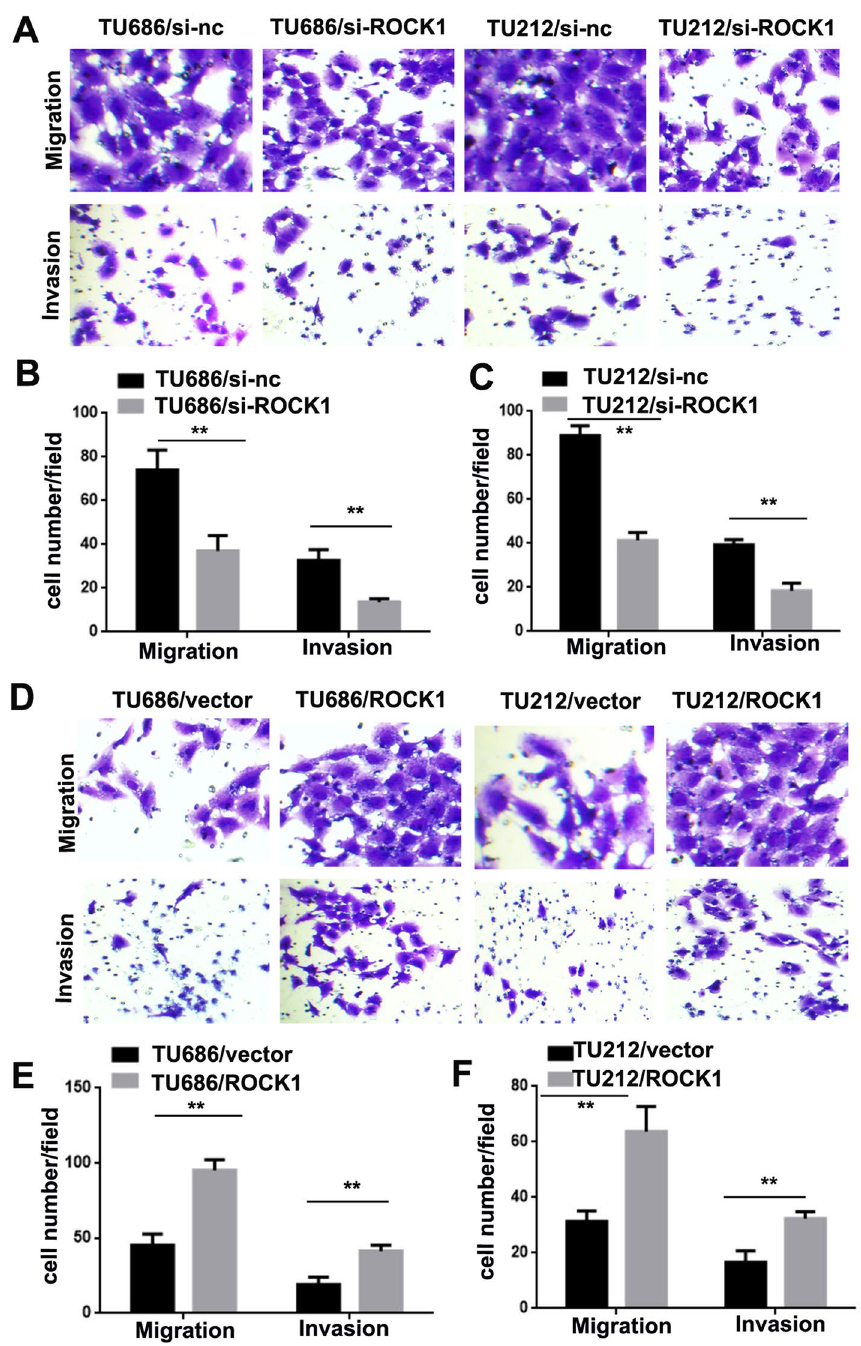
Fig. 3 ROCK1 promotes LSCC cell migration and invasion. A–C ROCK1 knockdown reduced TU686 and TU212 cells migration and invasion (**P < 0.01). D–F Overexpres- sion of ROCK1 induced TU686 and TU212 cells migration and invasion (**P <